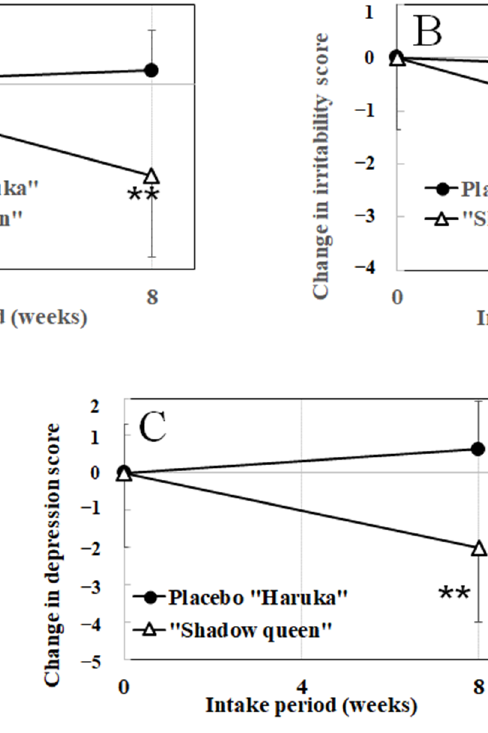
Figure 4. The changes in the brief job-stress questionnaire from week 0 to week 8. ( A ) Changes in the psychological stress response; ( B ) changes in irritability; and ( C ) changes in depression. Statistical significance: * p < 0.05; ** p < 0.01 vs. placebo group.